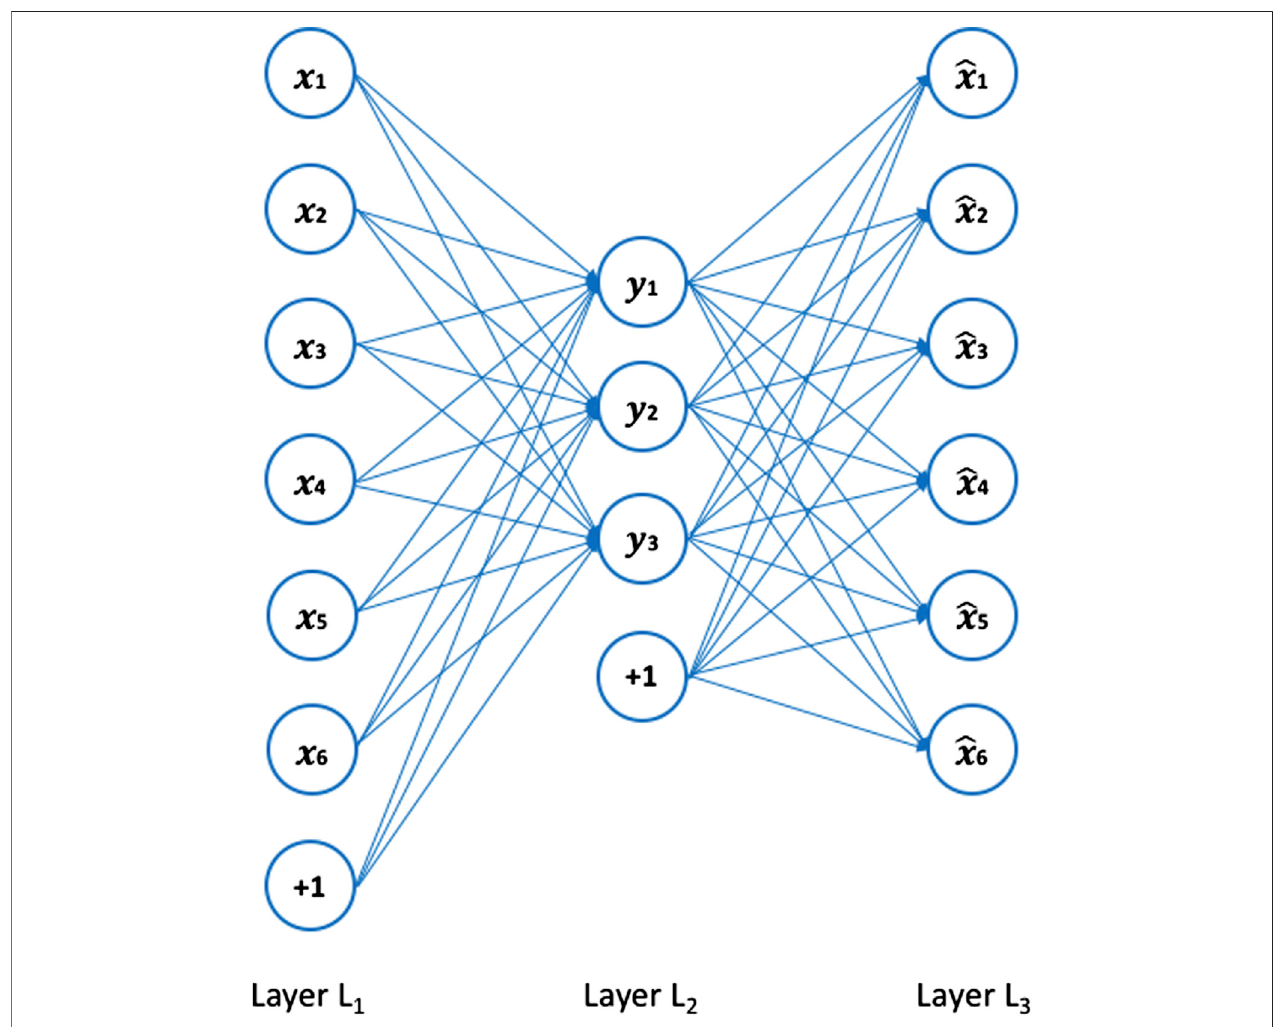
FIGURE1| Thearchitectureofanautoencoder,adaptedfromSakuradaandYairi(2014).LayerL 1 representstheinputdata,witheachcirclerepresentinganeuron correspondingtoameasurementbin,layerL 2 istheencoded datainlatent space,and layerL 3 isthereconstructed data.Thecircles labelled “ +1 ” are “ biasunits, ” which are parameters the autoencoder adjusts during training to improve its